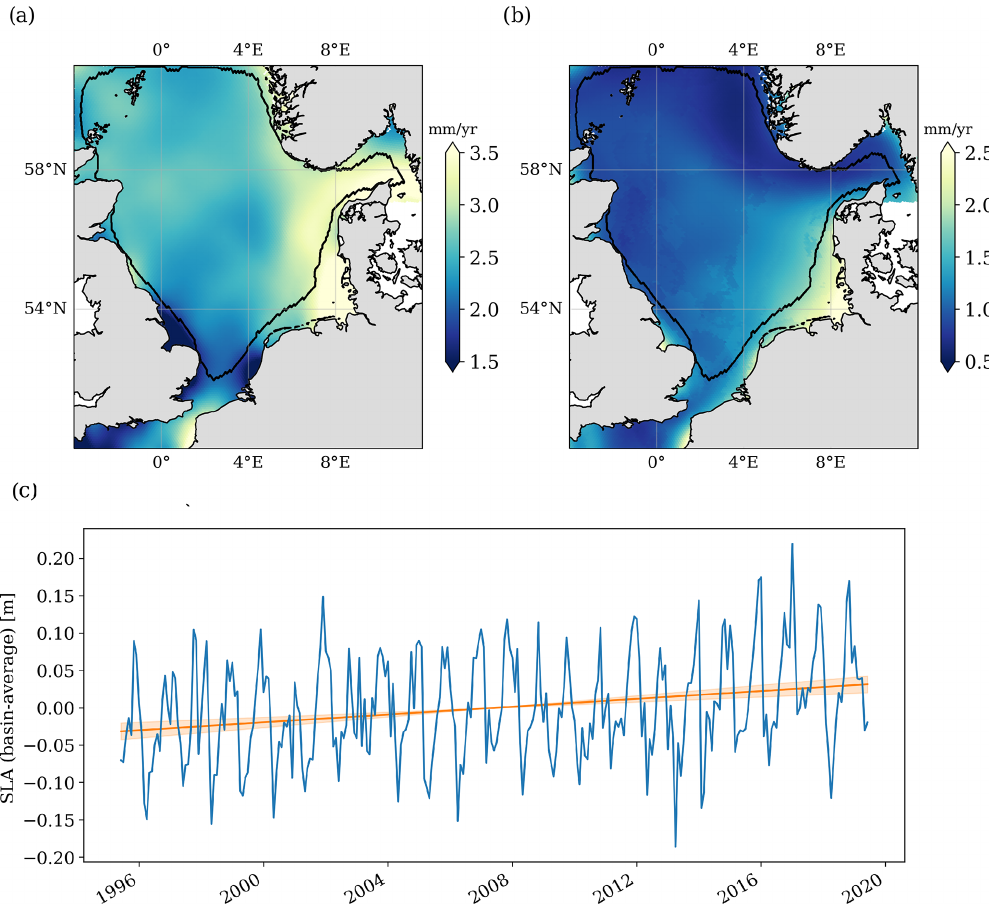
Figure 4. Sea level trends from altimetry (a) and their associated uncertainties (b) for the period between May 1995 and May 2019. The black contour line confines the coastal regions flagged in the dataset. The curve in (c) shows the SLA time series averaged over the entire North Sea. The linear trend is 2 . 61 ± 0 . 95mmyr − 1